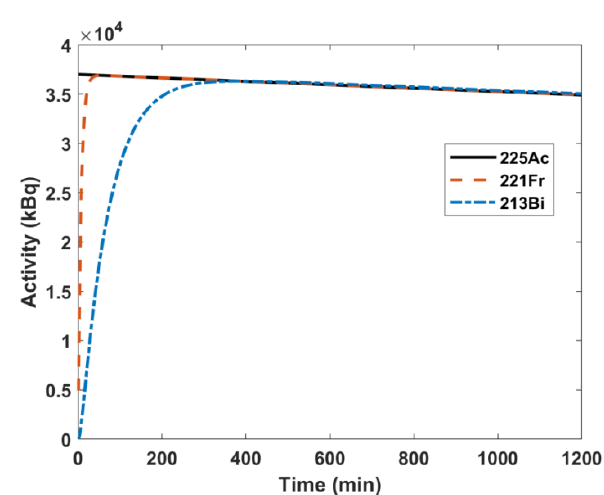
Figure 2. Solutions to system of decay ordinary differential equations of for an initial activity of 3.7 × 10 4 kBq of 225 Ac.